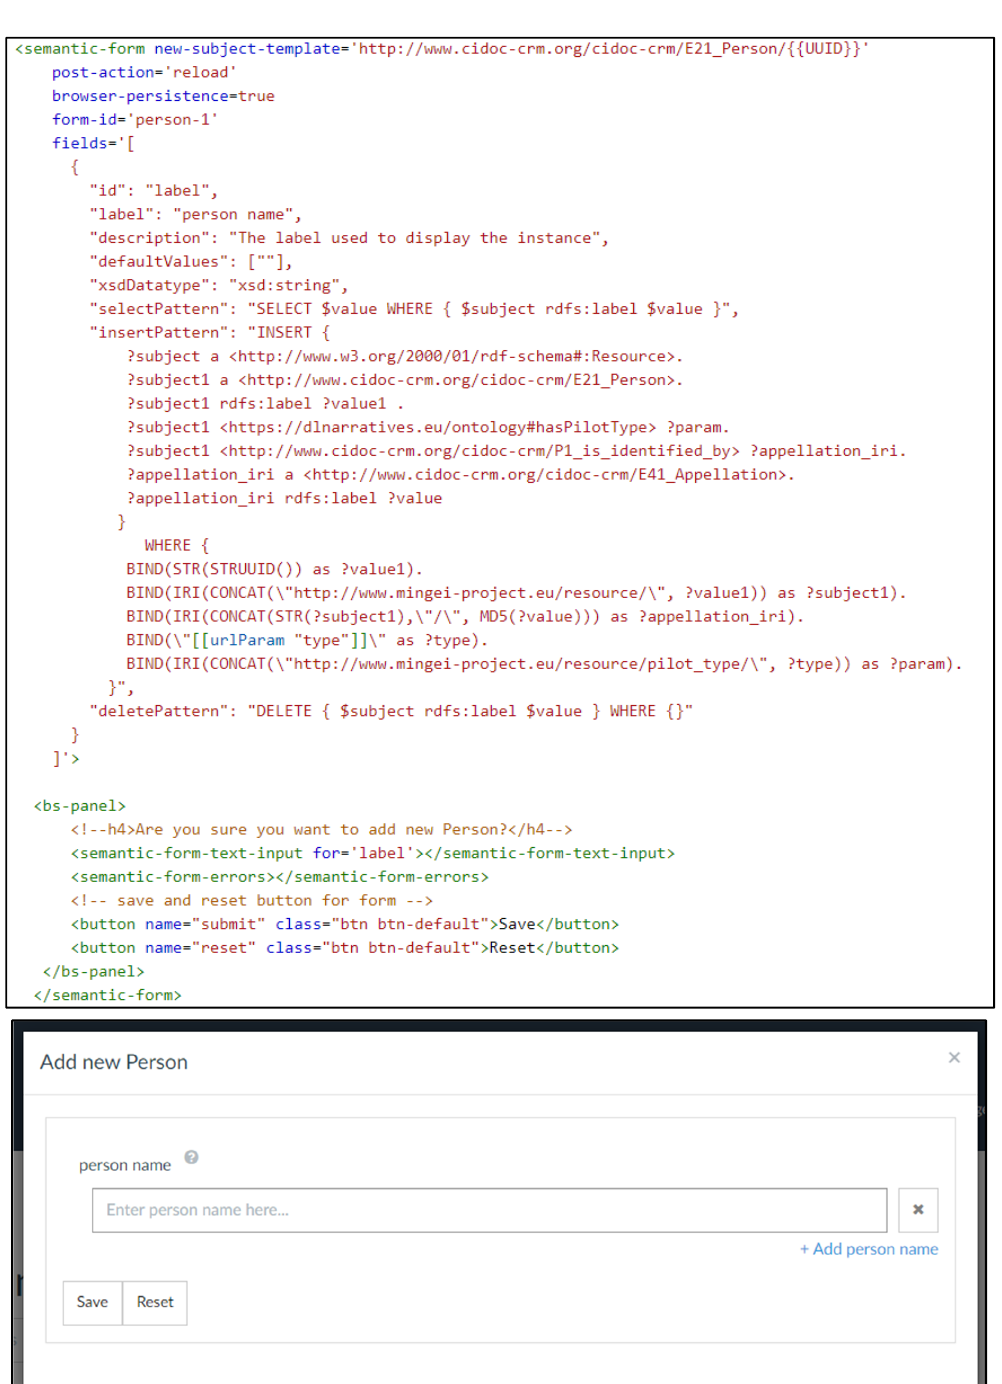
Figure 17. Creating simple and previewing a field definition.